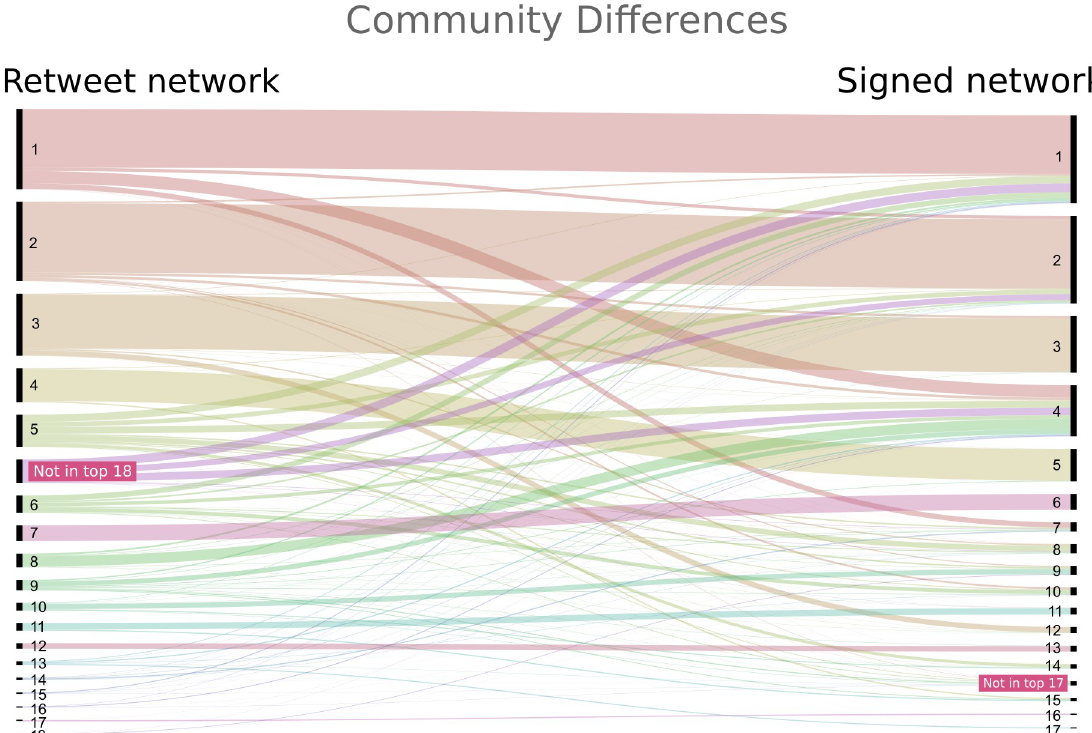
Fig 5. Community differences. Alluvial graph illustrating the relationships between the group structure in the retweet (left) and signed network (right). The thickness of the lines correspond to the number of users, and non-horizontal lines indicate differences between the group structures in the two networks. The figure shows considerable differences in the group compositions and illustrates that there are many central users in the signed network (n = 3.112) that are not in the top 18 communities of the retweet